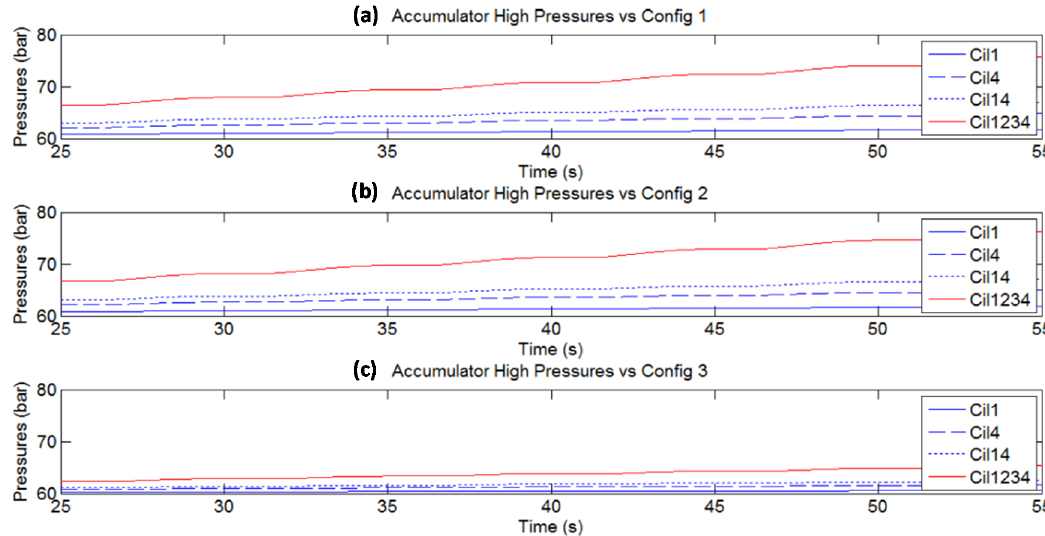
Figure 16. HP accumulator pressure Evolution. Comparison between different Geometrical configurations using the same activated hydraulic cylinders. ( a ) Config 1; ( b ) Config 2; ( c ) Config 3.